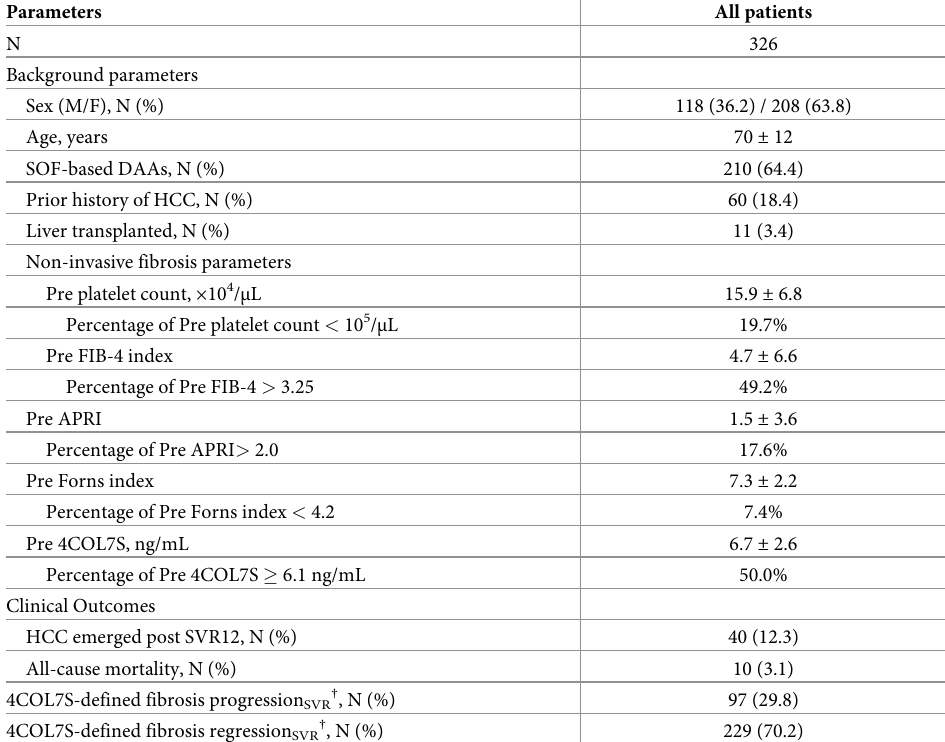
Table 1. Background characteristics, clinical parameters, and outcomes of the study